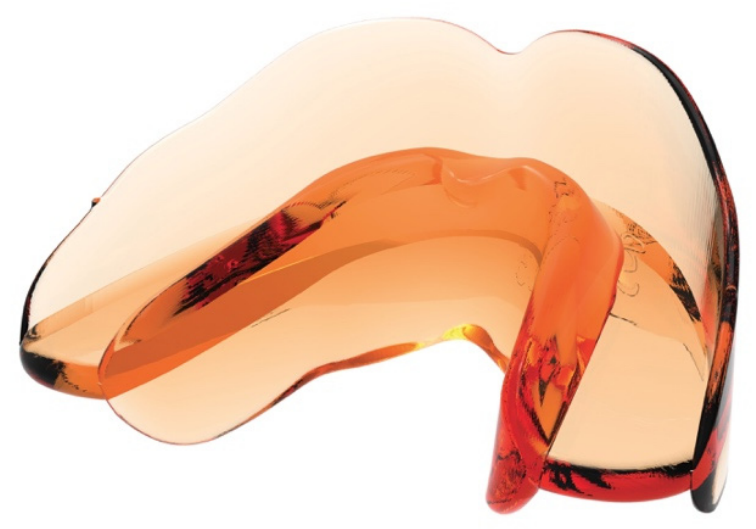
Figure 1. AMCOP second class (SC) appliance.